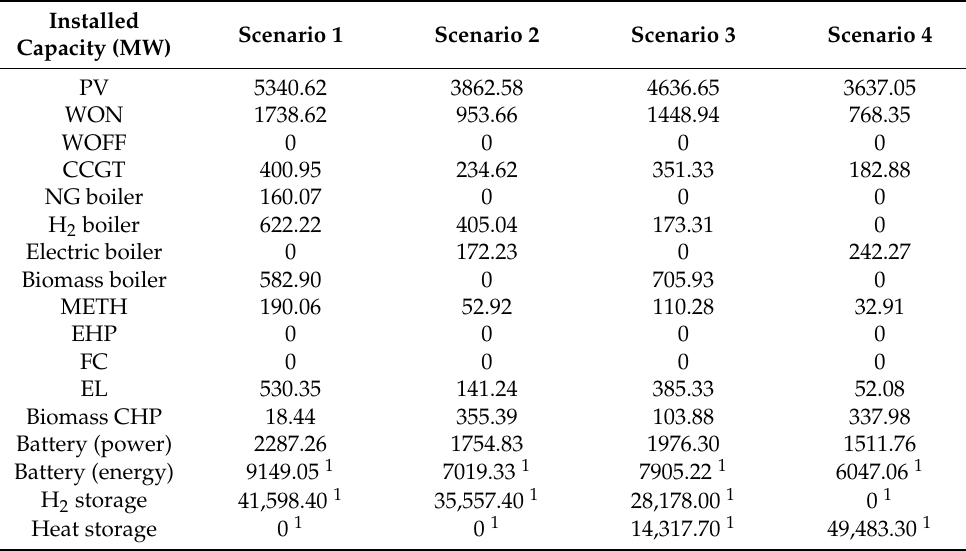
Figure 3. LCOE comparison for scenarios 1 to 4 of the case study. Table 3. Results of the case study: installed capacities for scenarios 1 to